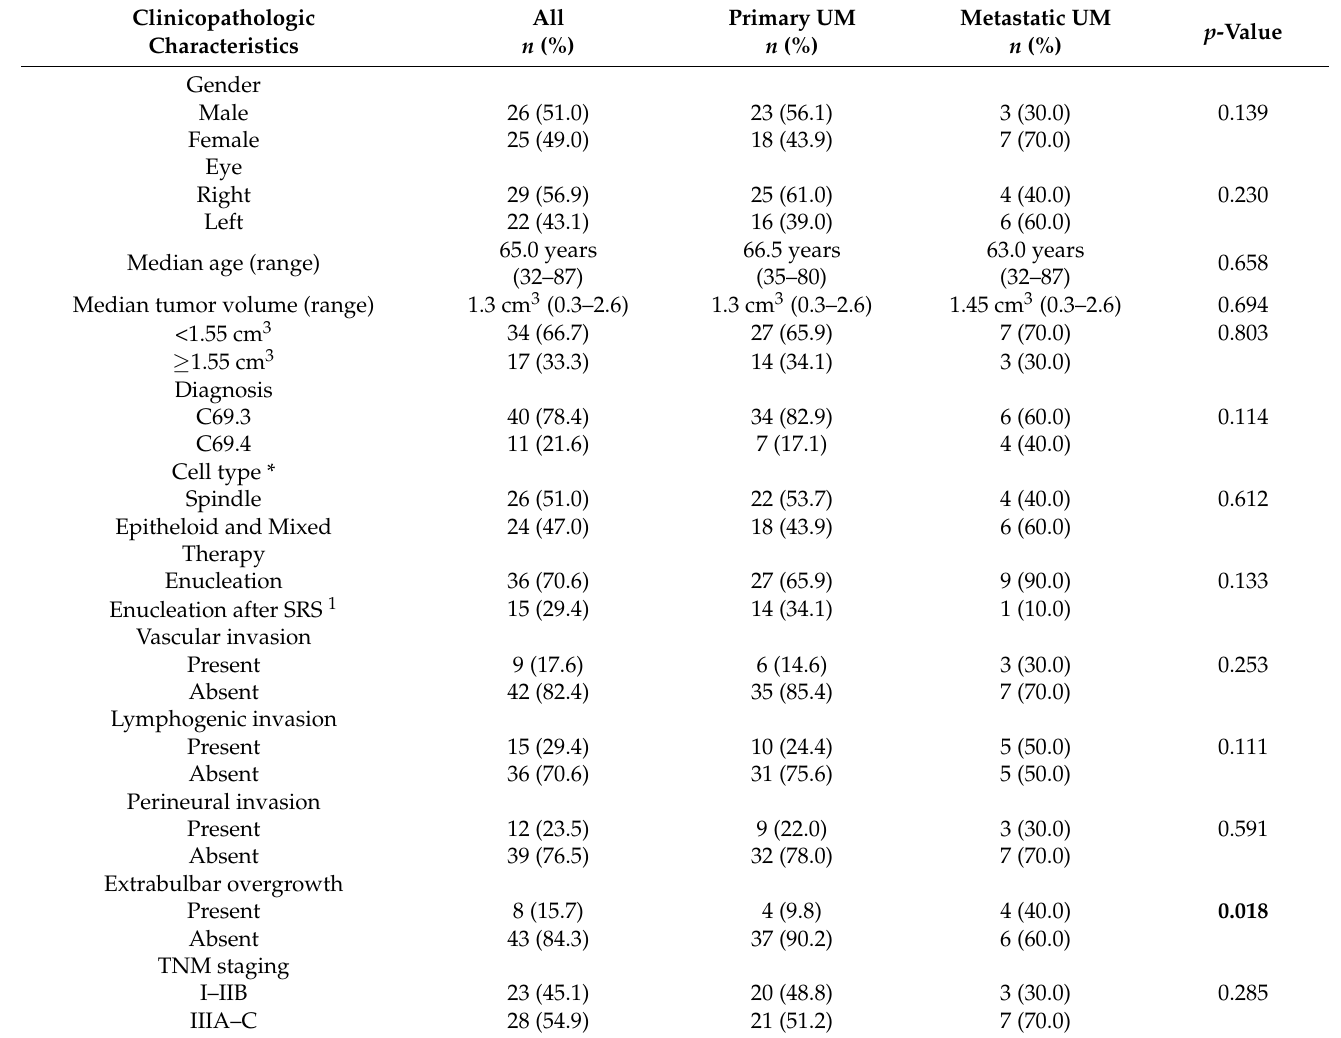
Table 1. Clinicopathologic characteristics of the enrolled